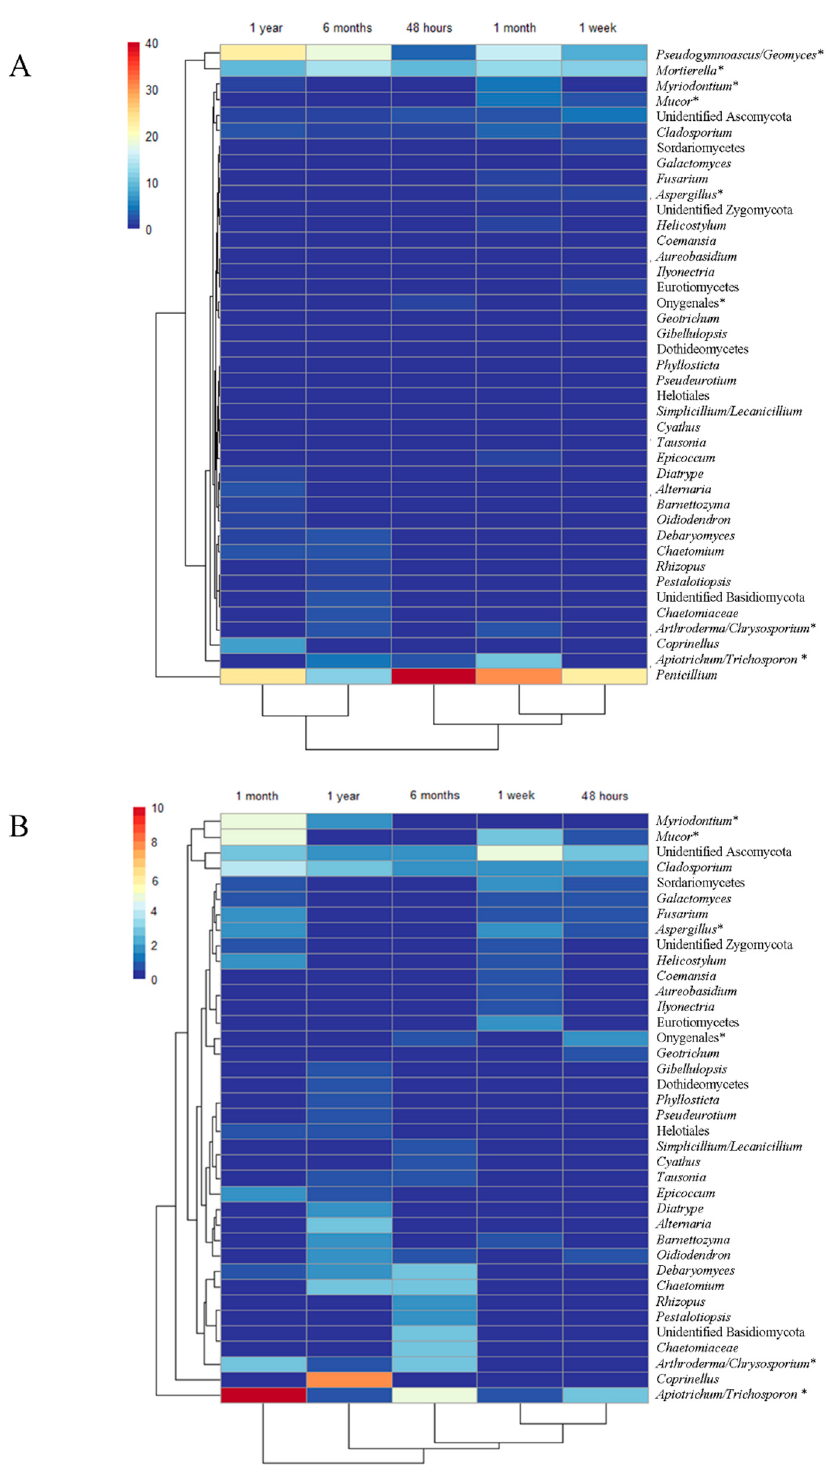
Figure 2. Pheatmap displaying fungal isolation patterns over storage time frame. ( A ) All Fungal taxa isolated; ( B ) Taxa isolated in low frequency. Panel ( A ) indicated 0–1 month were more similar to each other than 6 month–1 year based on storage time; Panel ( B ) demonstrates that low-frequency isolates were isolated more frequently at different time frames throughout the experiment. Potential fungal taxa indicated with an *.